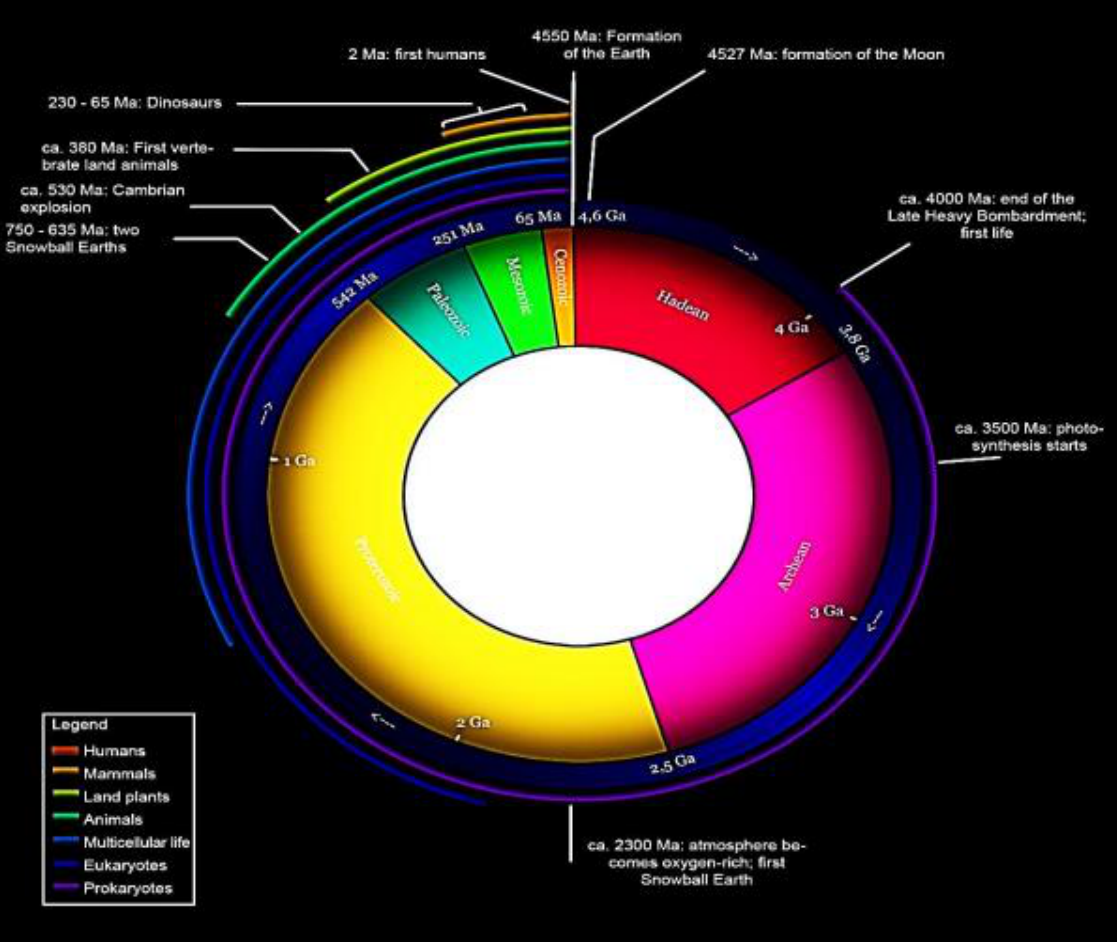
Figure 8. Schematic view of the evolution of life on